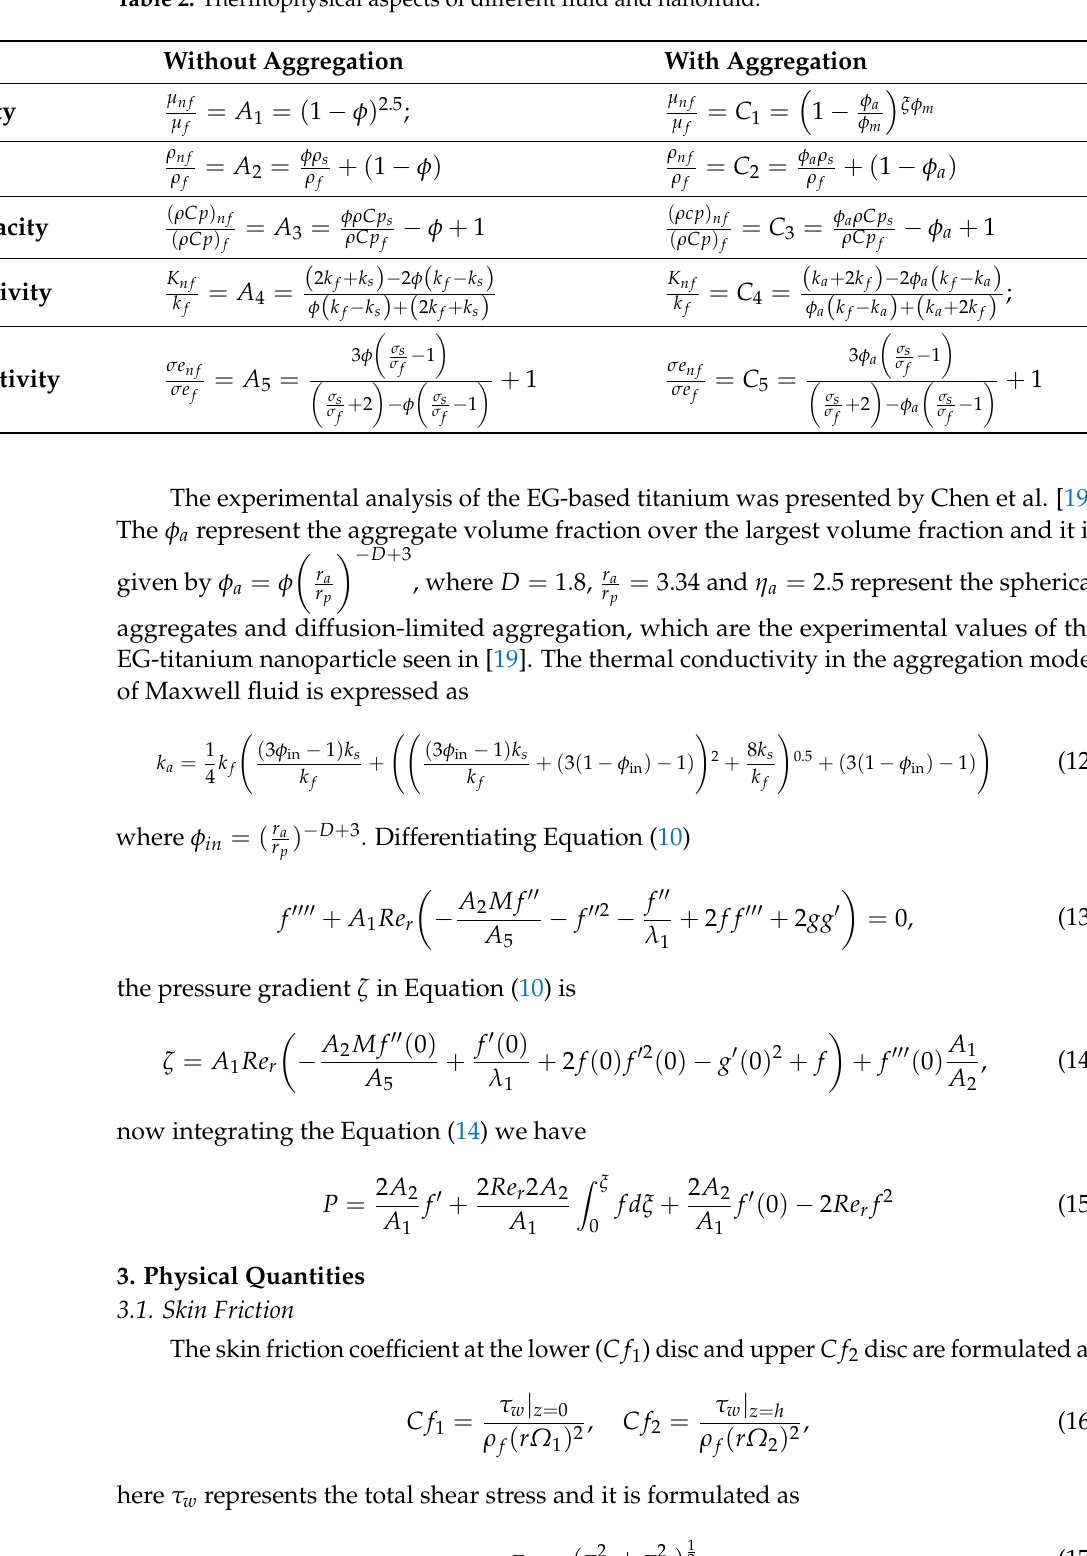
Table 2. Thermophysical aspects of different fluid and